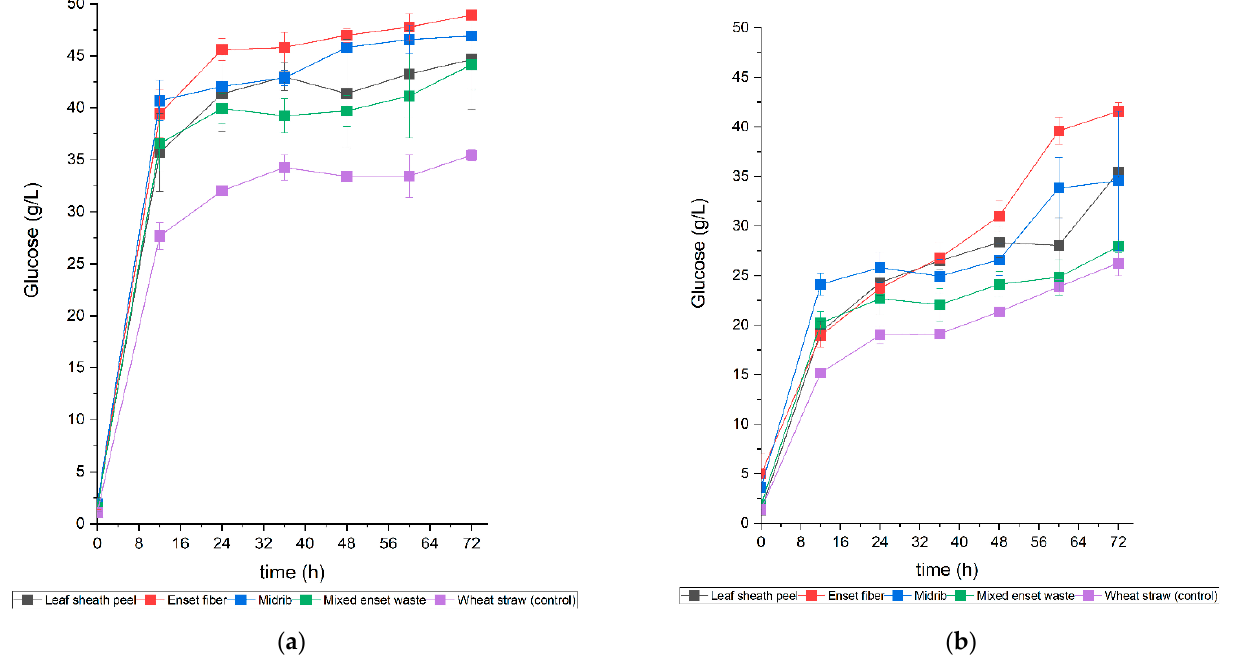
Figure 3. Glucose produced from enzymatic hydrolysis of Enset biomass samples with 5% (dry weight) solid loading, pretreated using different pretreatment methods: ( a ) alkali pretreatment method; ( b ) acid pretreatment method.